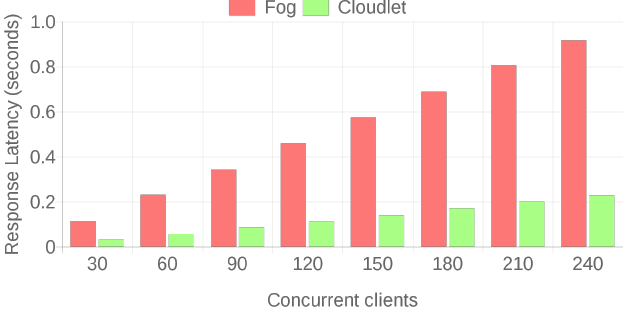
Figure 10. Latencies for 32B and 30 to 240 concurrent clients.